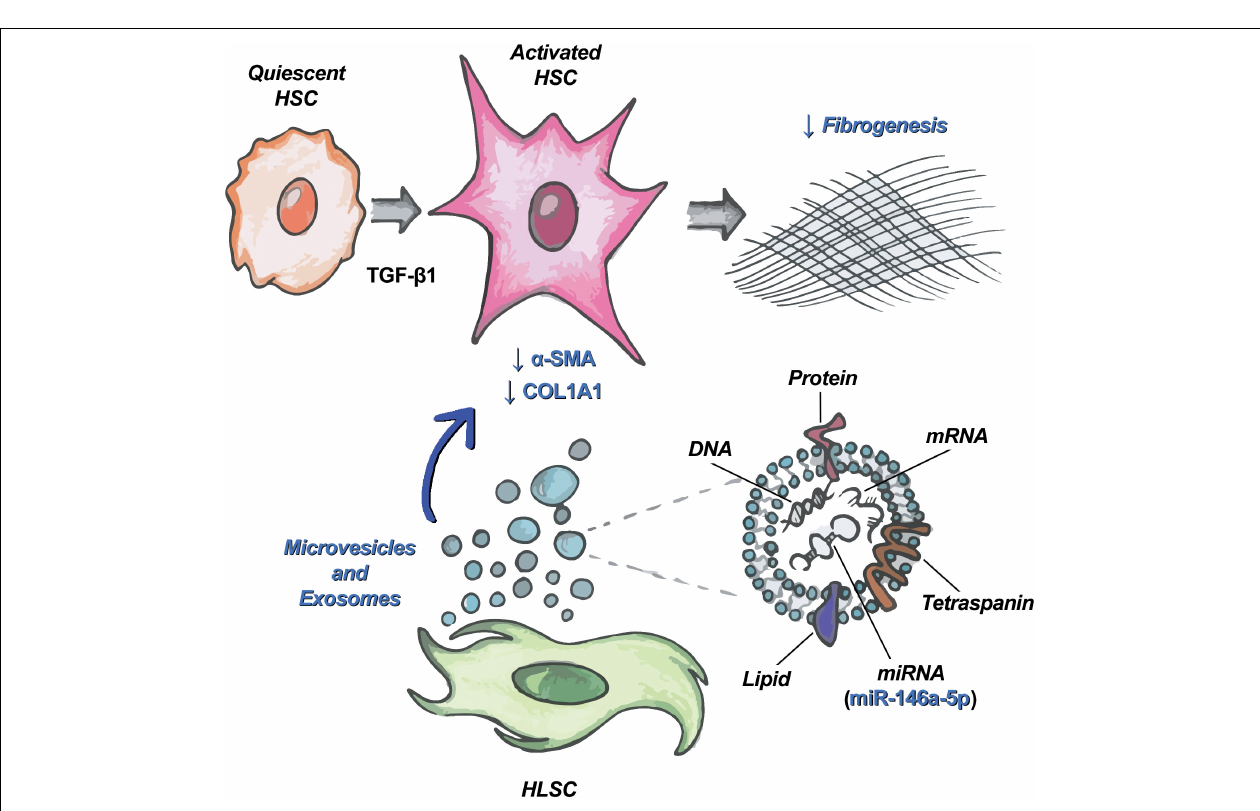
FIGURE 7 | HLSC-EVs target HSCs and attenuate their pro-fibrotic phenotype. Schematic representation of the mechanism of action of HLSC-EVs on HSCs activated by TGF- β 1. Among the molecules transported by HLSC-EVs in HSCs, miR-146a-5p contributes to the attenuation of the activated phenotype of HSCs.